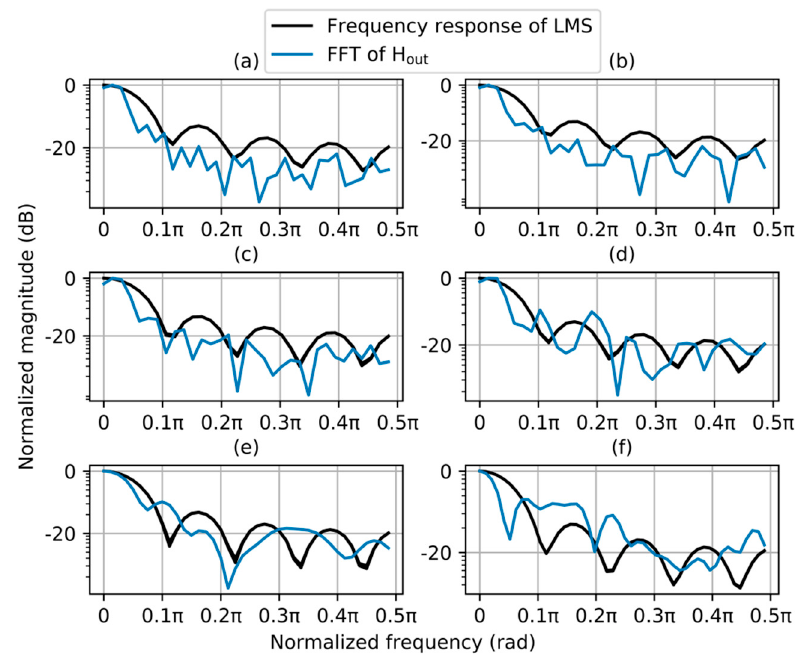
Figure 5. Frequency responses of LMS filter on sunny, partly cloudy, and overcast days, ( a ) 11, ( b ) 12, ( c ) 5, ( d ) 10, ( e ) 2, and ( f ) 8 December.